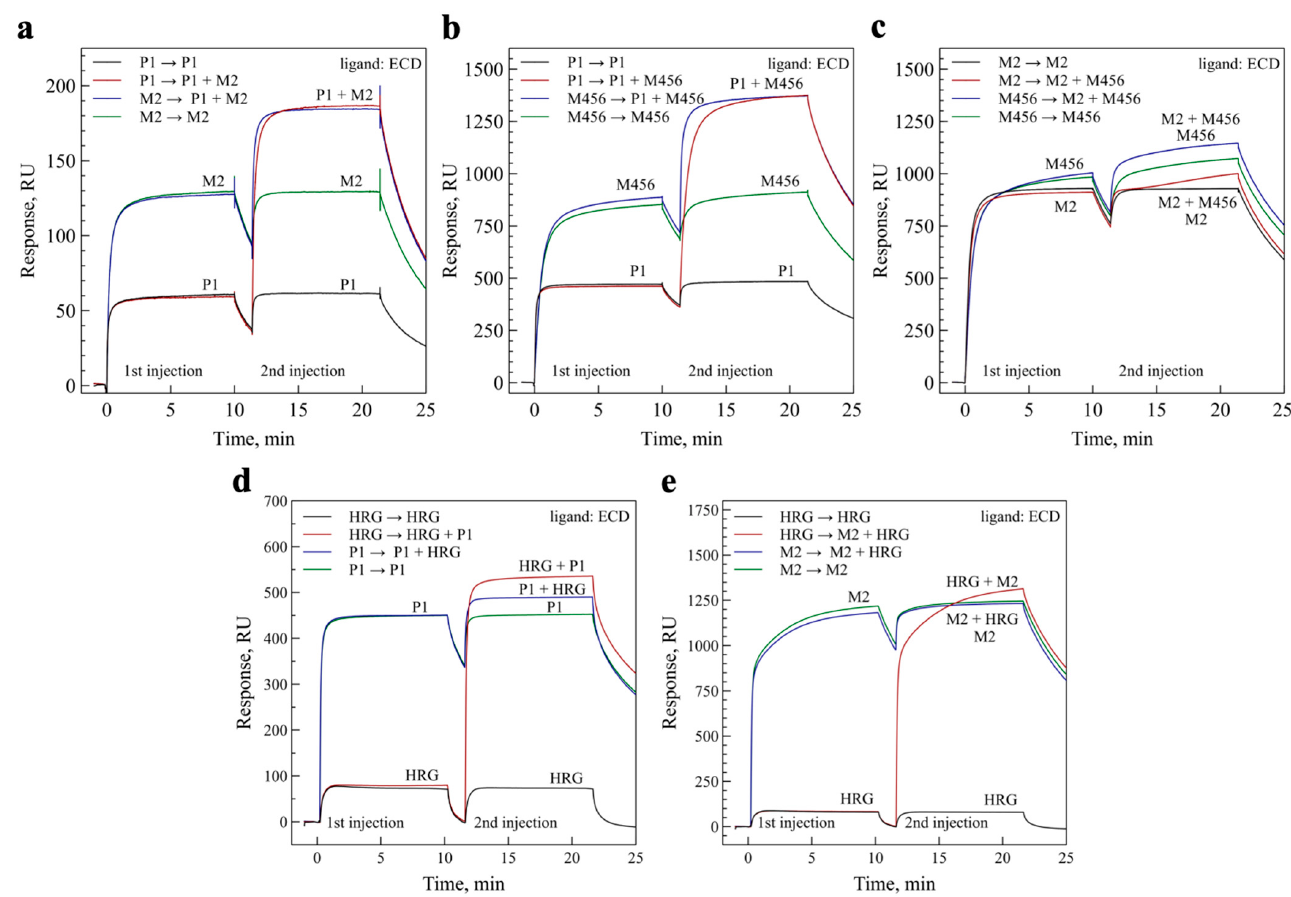
Figure 5. Epitope mapping by pairwise binding experiments and ligand competition. ( a ) Antibodies BCD090-P1 and BCD090-M2 bind simultaneously to ErbB3 ECD; ( b ) the same result is for BCD090-P1 versus BCD090-M456; ( c ) BCD090-M2 and BCD090-M456 attack the overlapping epitopes as seen from the lack of simultaneous binding; ( d ) BCD090-P1 does not block the binding of natural ErbB3 ligand, heregulin; ( e ) saturation of ECD with BCD090-M2 completely abolishes ligand binding.